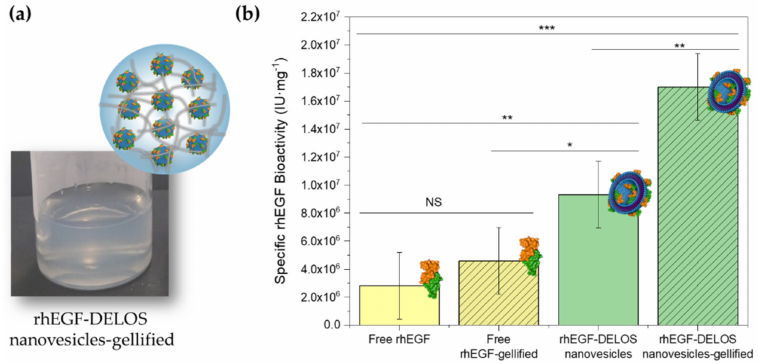
Figure 8. ( a ) Macroscopic image of the rhEGF-DELOS nanovesicles-based hydrogel using CTAB as surfactant and 5 mM histidine, pH = 7, as media; ( b ) in vitro specific biological activity of free rhEGF and rhEGF-DELOS nanovesicles in a cell proliferation assay in 3T3 A431 murine fibroblast cell line. Free rhEGF and rhEGF-DELOS nanovesicles 100 µ g mL − 1 were formulated in aqueous solution or in Methocel TM K4M hydrogel. Data plotted as mean ( n = 3 per group) specific bioactivities are represented by the heights of bars with 95% confidence intervals represented by the error bars. Statis- tical analyses were done by one-way ANOVA followed by Tukey pairwise comparison. * p < 0.05, ** p < 0.01, *** p < 0.001 and NS: non-significant